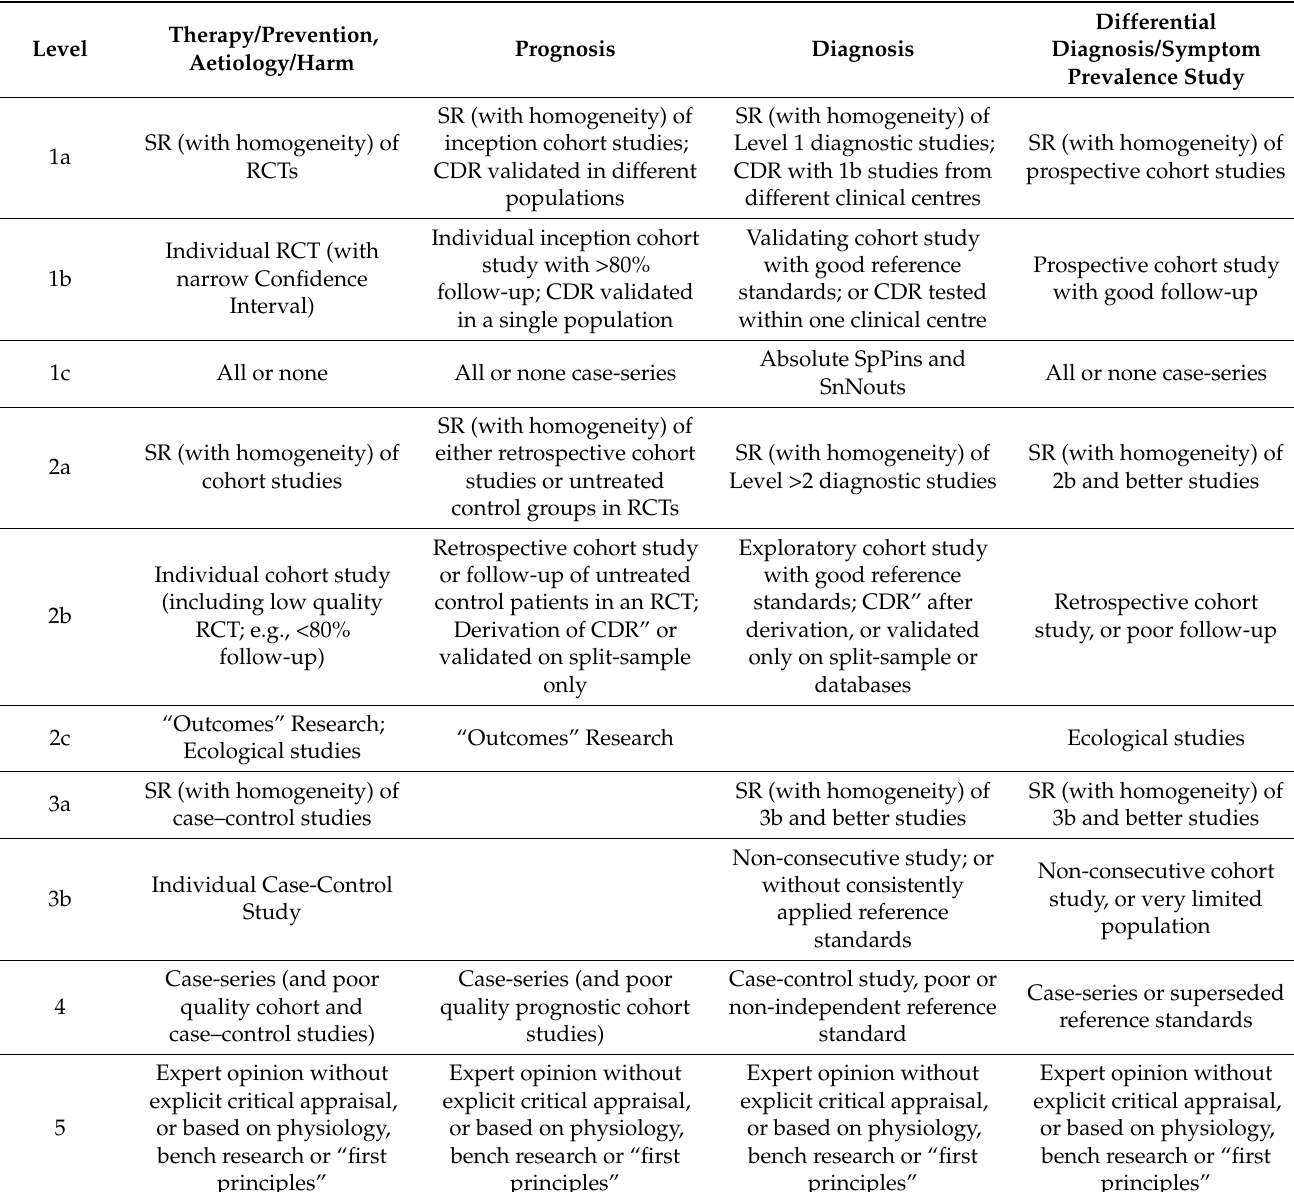
Table 1. Hierarchy from the Oxford Centre for Evidence Based Medicine, reproduced from: https:// www.cebm.net/2009/06/oxford-centre-evidence-based-medicine-levels-evidence-march-2009/, ac- cessed on 17 September 2022. RCT = Randomized Controlled Trial, SR = Systematic Review, CDR = Clinical Decision Rule, Absolute SpPin = a diagnostic finding whose Specificity is so high that a Positive result rules-in the diagnosis, Absolute SnNout = a diagnostic finding whose Sensitivity is so high that a Negative result rules-out the